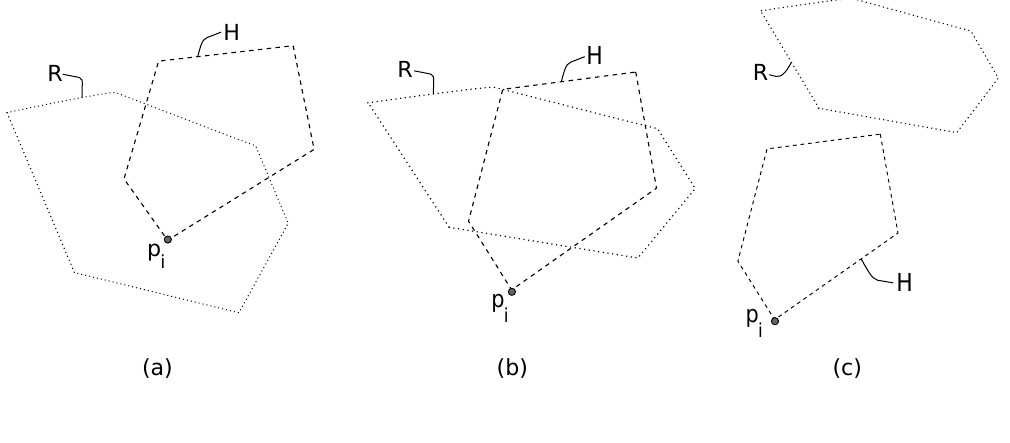
inside R , (b) node i i